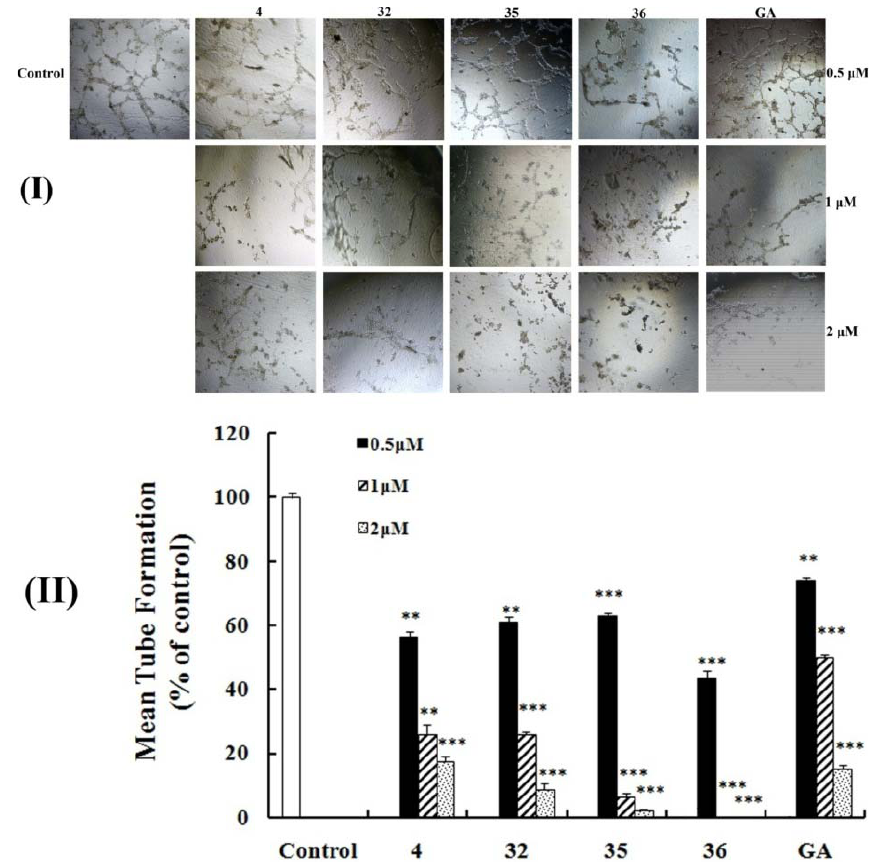
Figure 4. Effects on the HUVECs tube formation. ( I ) HUVECs (1 × 10 4 cells) suspended in DMEM containing each compound (0.5 or 1 or 2 μ M) were added to the Matrigel. Control was treated with DMEM alone. After incubation for 6 h at 37 °C, capillary networks were photographed and quantified (Olympus CKX41, magnification: 100×); ( II ) Rates of the HUVECs tube formation. The number of intact tubes was counted in five randomly chosen regions and expressed as the percentage of the control. The results were